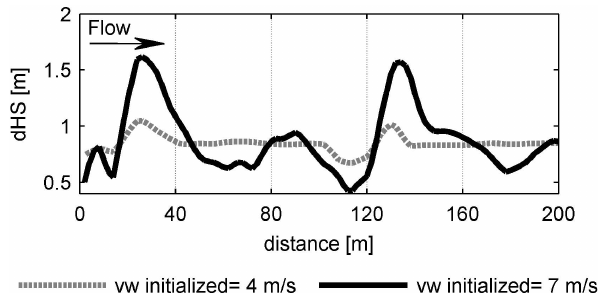
Fig. 8. Transect of modeled dHS crossing the two cross-slope ridges in flow direction, caused by high (initialized vw = 7ms − 1 ) and moderate (initialized vw = 4ms − 1 ) wind velocities. The transect is indicated in Fig. 1,